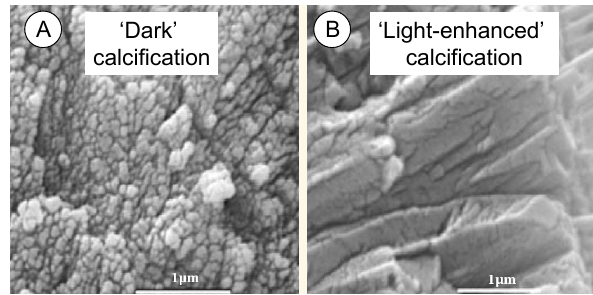
Fig. 3. Distinct skeletal units of Porites skeleton associated with “dark” and “light-enhanced” calcification phases. (A) At night, a new cluster of sub-micron granular (equant) crystals are deposited on the tips of pre-existing skeletal elements. (B) At daybreak, long, needle-shaped crystals grow from the “seed” crystals and are bun- dled into fan-shaped fascicule. (Images courtesy of Anne Cohen, Woods Hole Oceanographic Institution.)